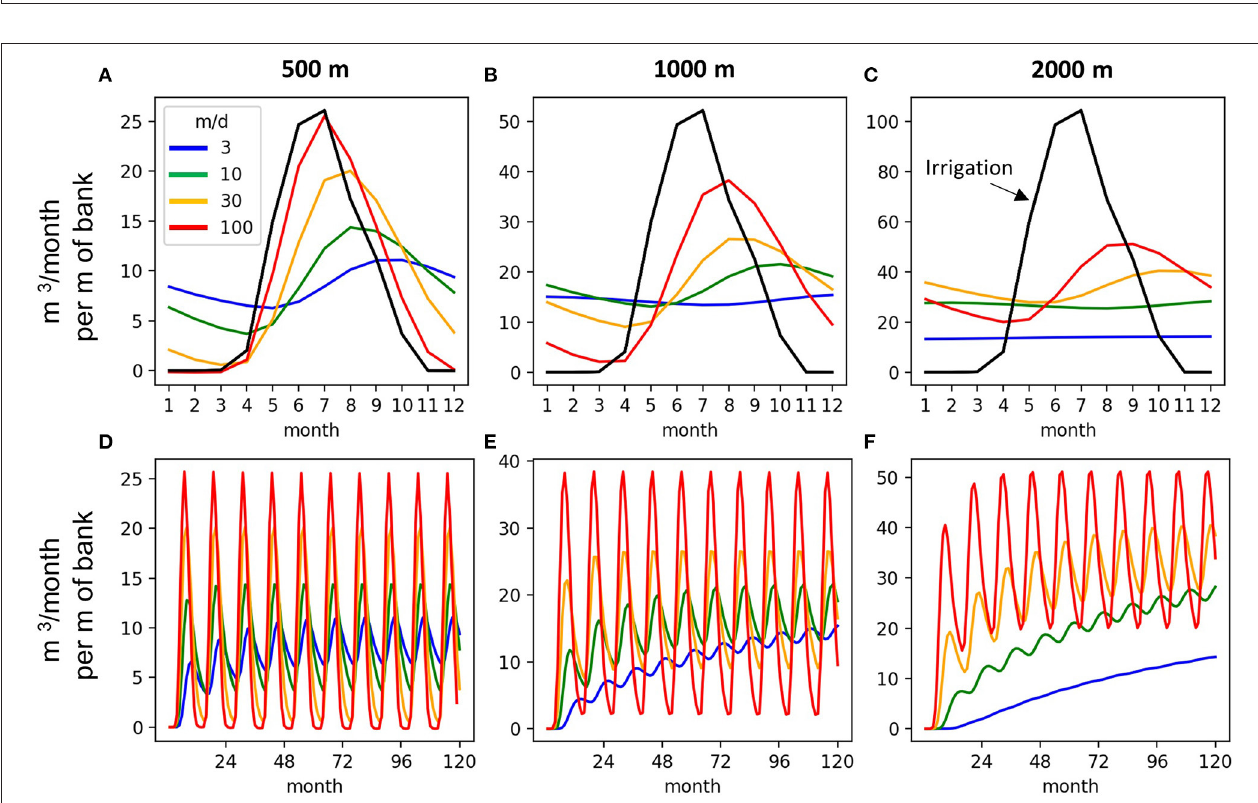
Comparison to Analytical Solution The gray lines in Figure 6 show the analytical solution corresponding to the scenarios with a 20 m thick aquifer with a Sy of 0.3 (solid orange line). The results for the orange solid